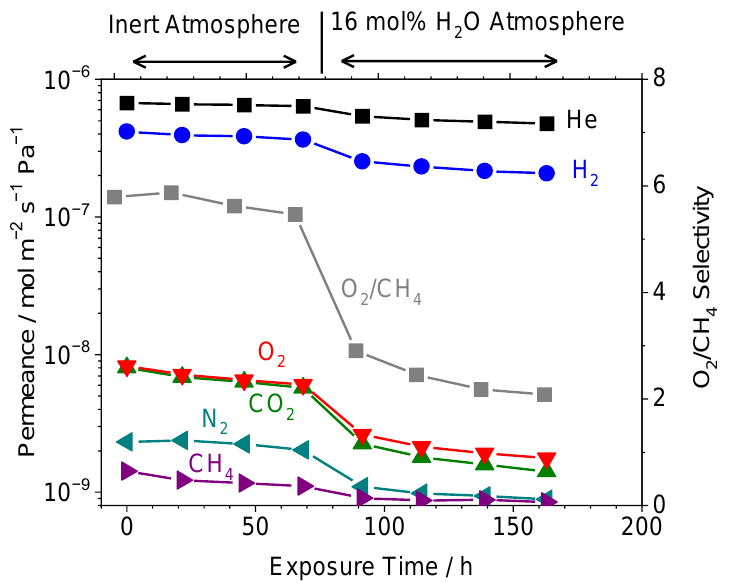
Figure 8. Pure gas permeance of various gases at 650 °C versus time of exposure to either Ar (0 – 69 h) or 16 mol% H 2 O in Ar (69 – 163 h) for the Si-40Ta-650 membrane. Permeance measurements taken during short interruptions of the steam exposure.